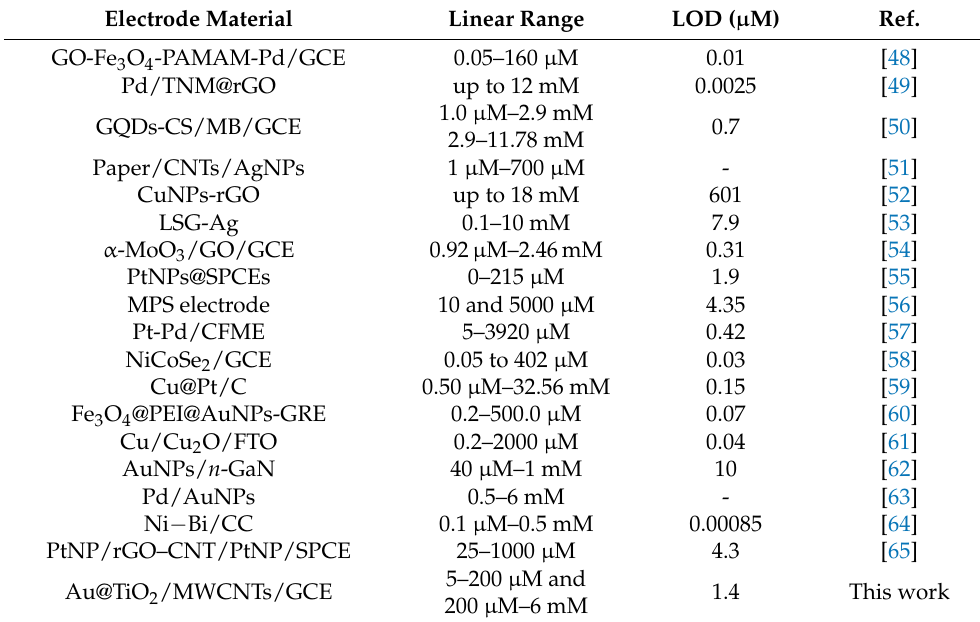
Table 2. Comparison of the proposed sensor with the recently reported H 2 O 2 sensors.